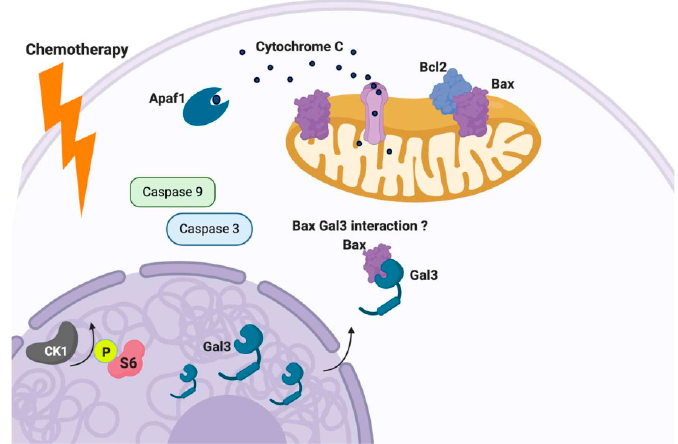
Figure 4. Galectin-3 as an inhibitor of the apoptotic response. Gal-3 can translocate from the cytosol and/or the nucleus to the mitochondria, inhibiting stressors of the mitochondrial membrane potential and subsequent release of Cyt C. In response to apoptotic stimuli, Gal-3 can translocate to the mitochondria and interact with Bax and prevent its function, as well as other pro-apoptotic Bcl-2 family members, subsequently preventing the formation of pro-death promoting